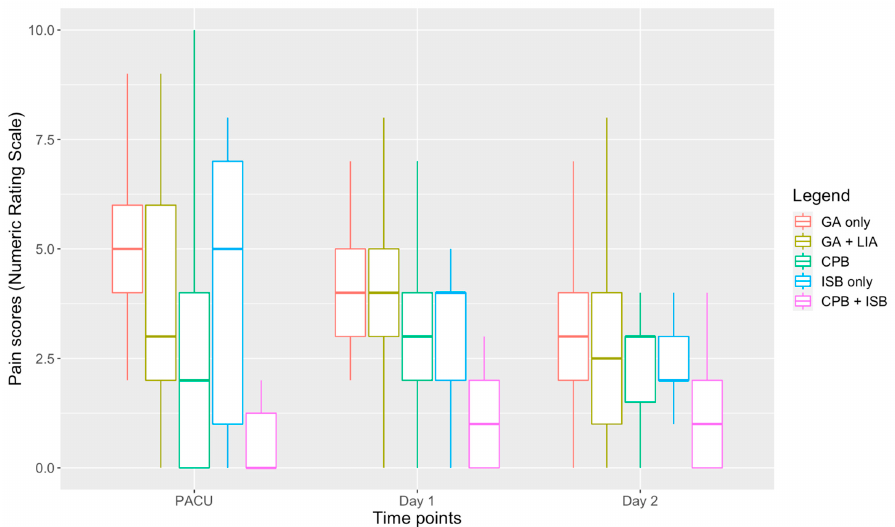
Figure 1. Comparison of pain scores of patients who received general anesthesia alone, compared to those who received different combinations of regional anesthesia. Abbreviations: CPB, cervical plexus block; PACU, post-anesthetic care unit.